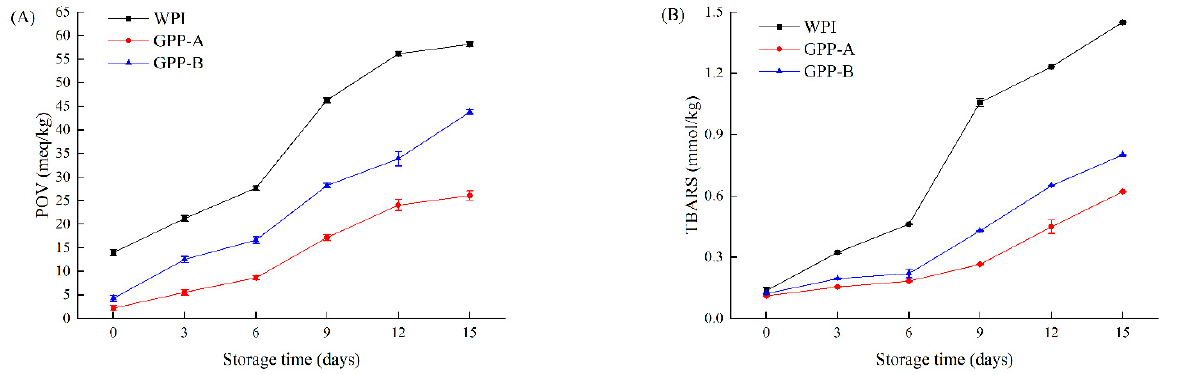
Figure 2. Changes in POV ( A ) and TBARS ( B ) of CLA emulsions stabilized by GPP-A and GPP-B ◦ during storage for 0–15 days at 25 °C. during storage for 0–15 days at 25